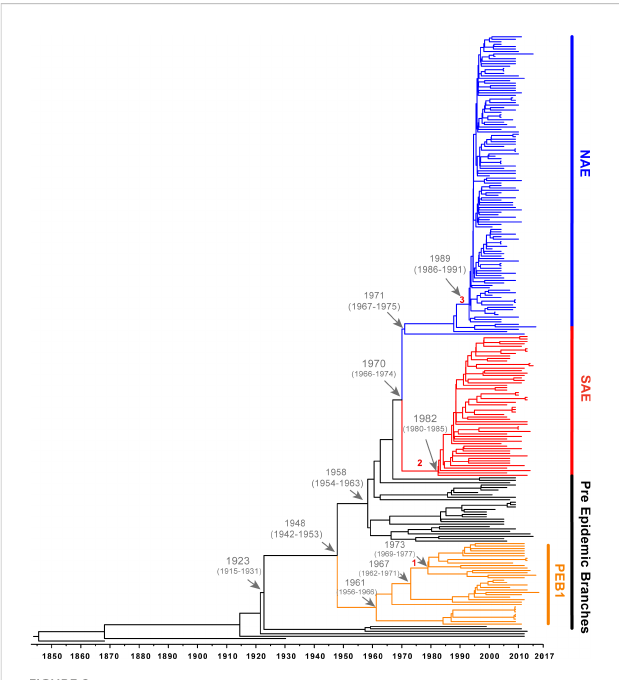
FIGURE 2 Bayesian maximum clade tree calculated from 54001 sampled trees.